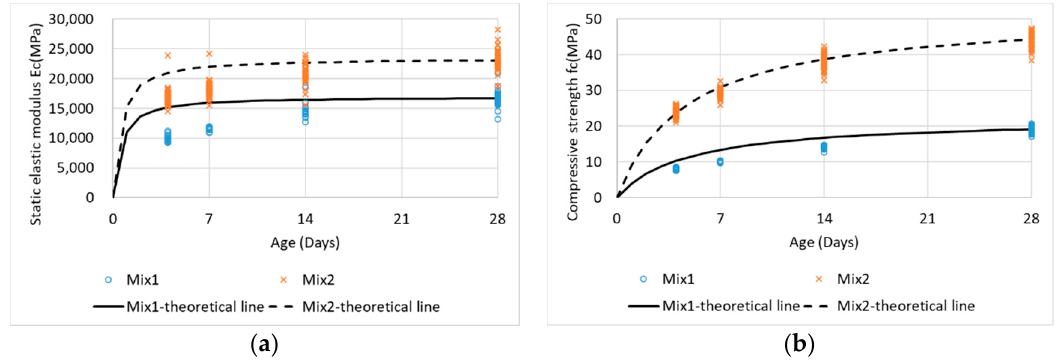
Figure 7. Comparison of experimental and theoretical values for Ec and fc. ( a ) Static elastic modulus; ( b ) Compressive strength. Table 3. Comparison of experimental (mean) and theoretical values for Ec and fc.